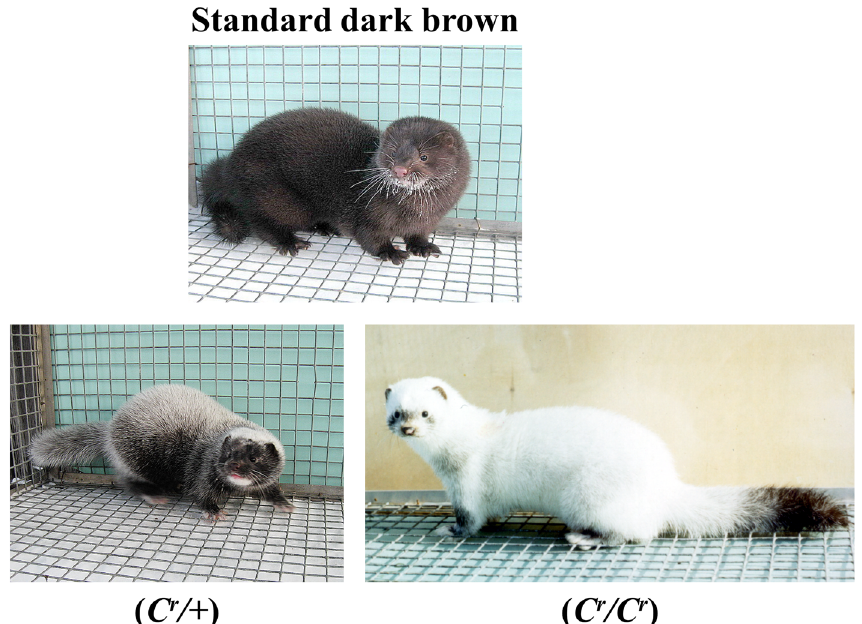
Figure 1. American minks with the standard dark brown, Black crystal heterozygous ( C r / +) and Black crystal homozygous ( C r /C r ) phenotypes.